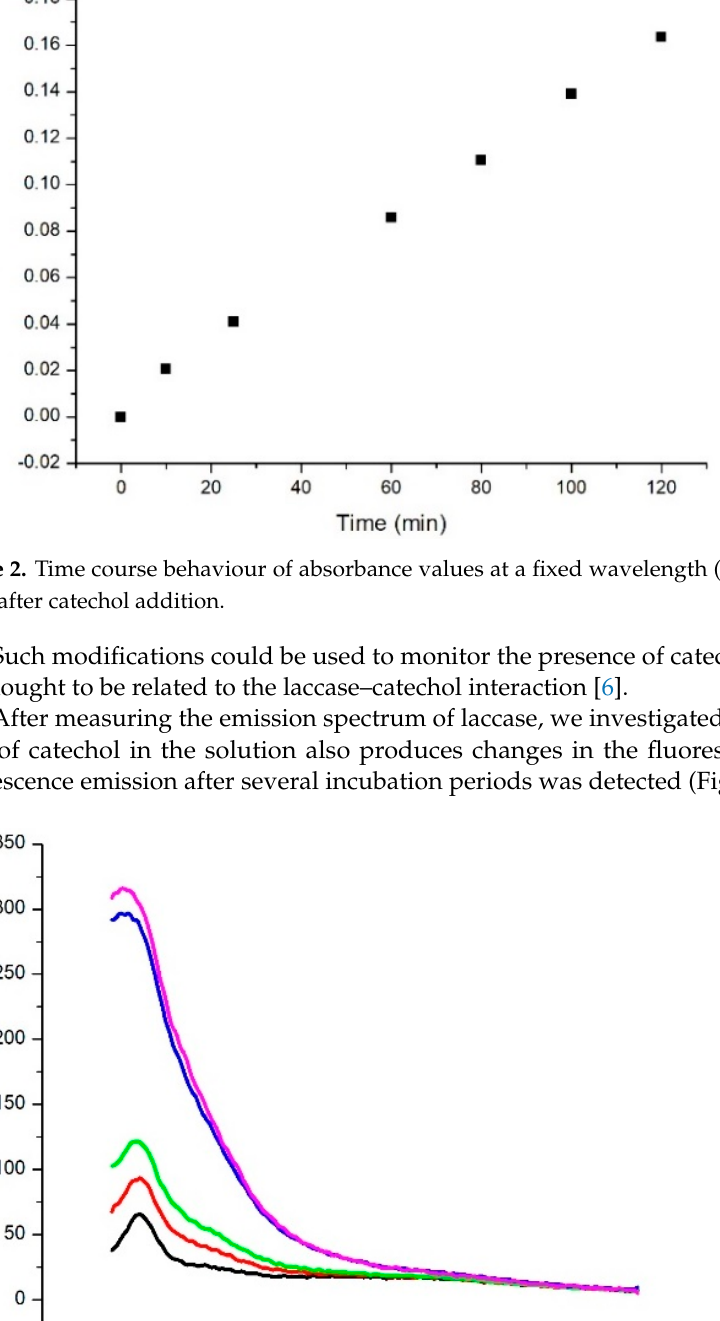
Figure 4. Time course behaviour of emission values at a fixed wavelength (360 nm). Measurements were performed at various times: immediately after catechol addition, 5 min, 10 min, 50 min and 80 min after catechol addition.